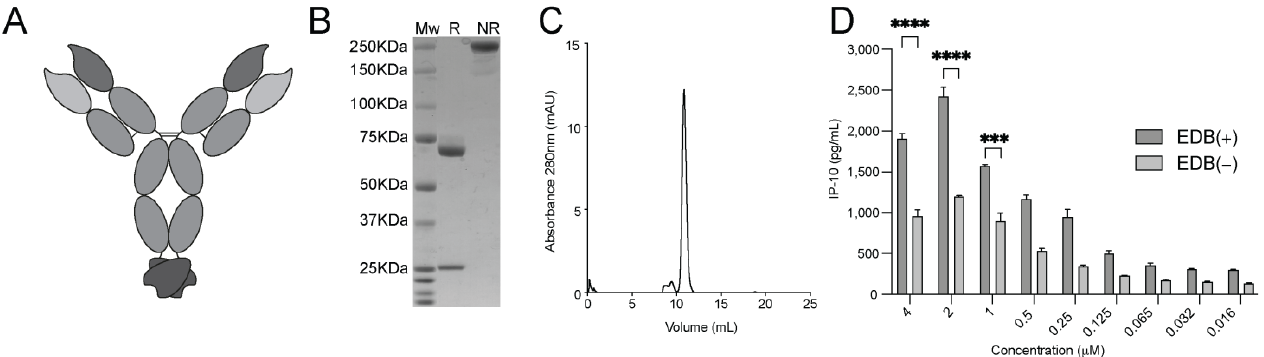
Figure 3. Murine L19-IFN γ KRG characterization. ( A ) Schematic representation of L19-mIFN γ KRG. ( B ) SDS gel electrophoresis, 10% gel in reducing (R) and non-reducing conditions (NR) of L19-mIFN γ -KRG. ( C ) Size exclusion chromatogram of L19-mIFN γ -KRG. ( D ) IP-10 release on TIB-49 murine leukaemia cells exposed to titration of L19-mIFN γ KRG in coated EDB (+) and non-coated EDB ( − ) wells. (***: p < 0.001, ****: p < 0.0001).